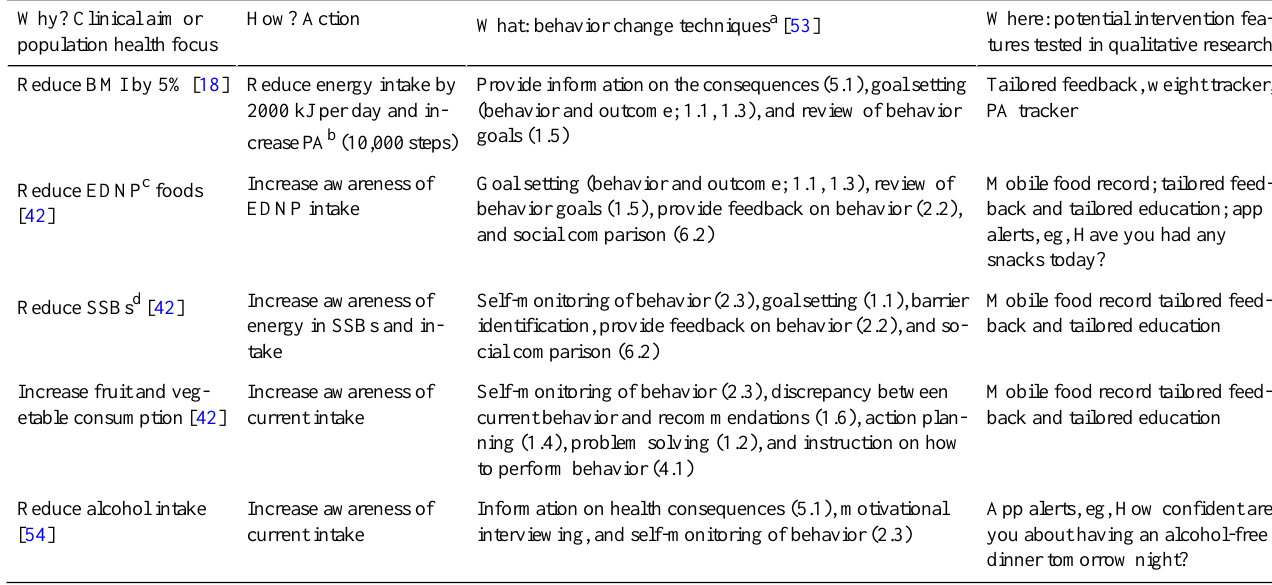
Table 1. Relationship among clinical aims, behavior change techniques, and intervention features (technology).